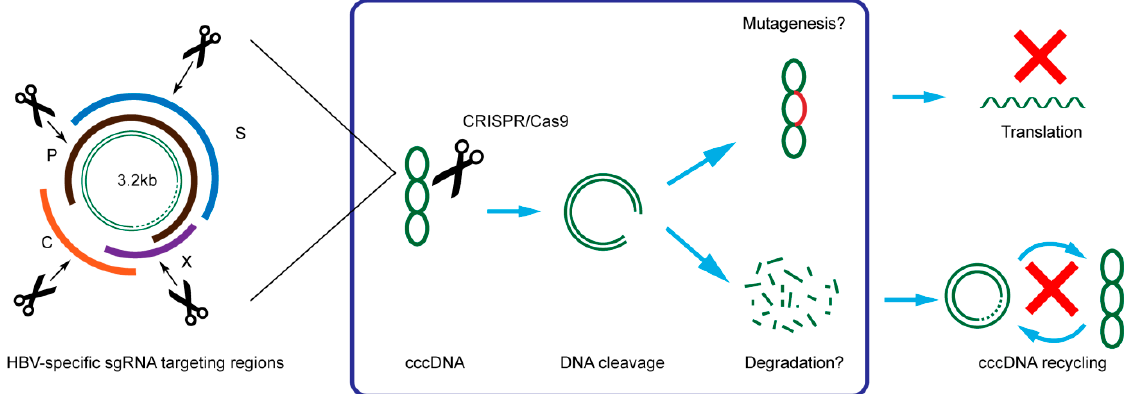
Figure 3. Illustration of HBV targeting strategy and possible mechanism of CRISPR/Cas9 in suppression of HBV. C: core; P: polymerase; S: surface; X: HBx.